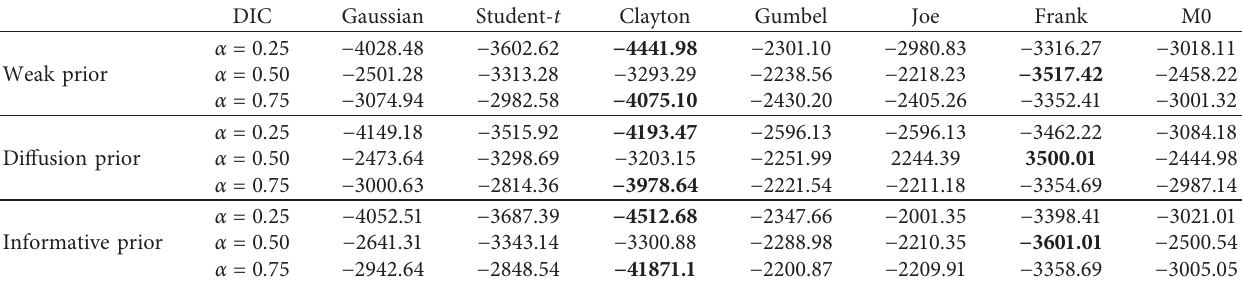
Table 8: Model selection and prior sensitivity check.